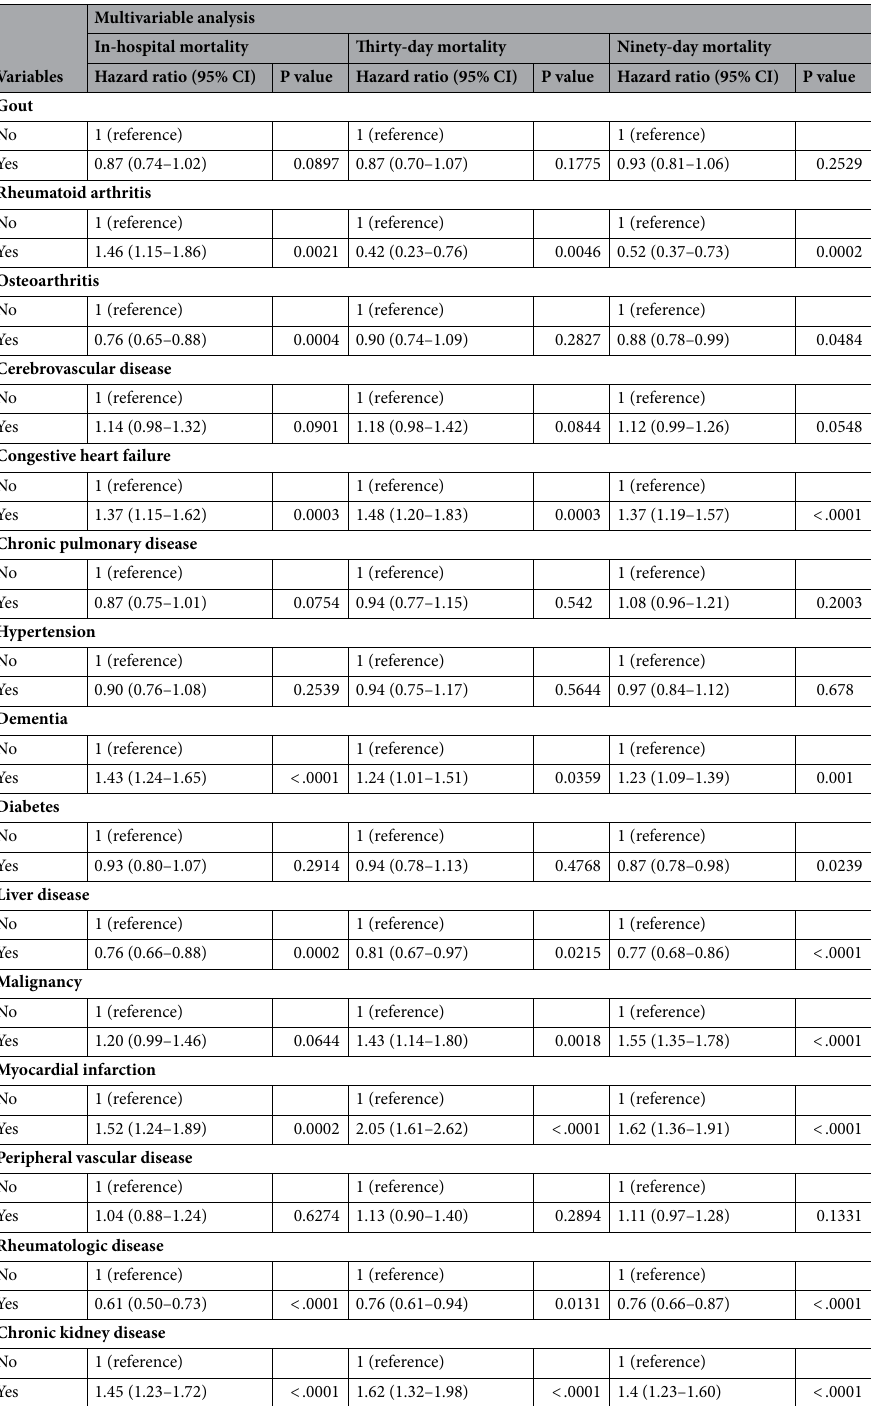
Table 6. Cox proportional hazard models of in-hospital, thirty-day, ninety-day mortality by